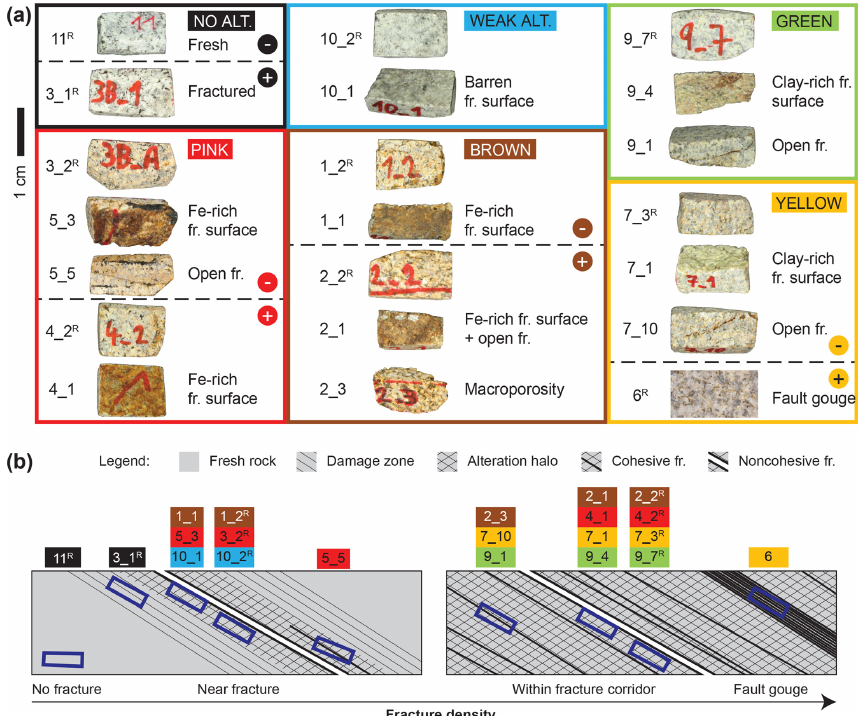
Figure 3. (a) Photographs and parametric description of specimens tested by mercury porosimetry grouped by alteration facies. The dashed lines delimit subgroups of specimens from lower (minus symbol) and higher (plus symbol) fracture density zones; (b) schematic sketch of rock cores and sampled materials showing in a simplified way the position of the specimens within the core samples. Specimens indexed with “R” were selected as representative of the matrix of the facies. Alt.: alteration, fr.: